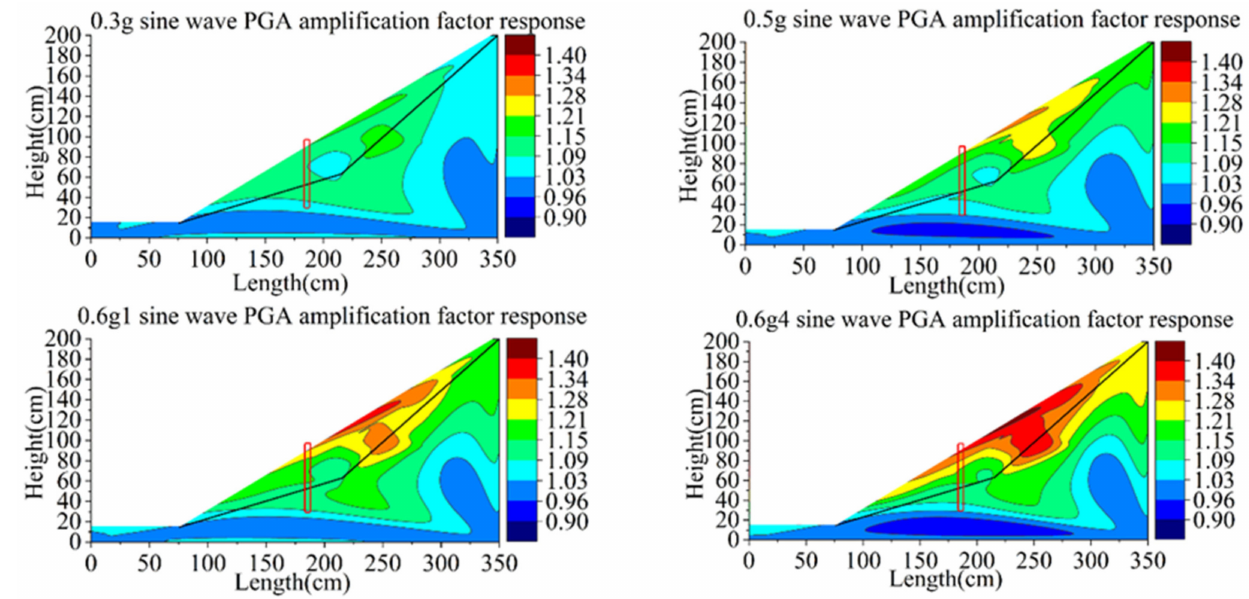
Figure 14. Contours of PGA amplification coefficient of model